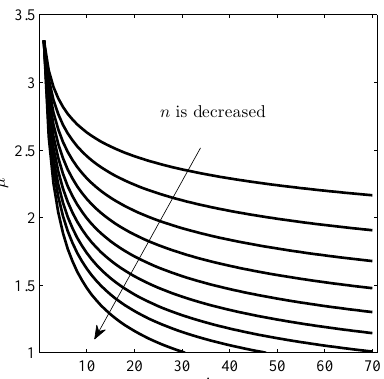
Figure 3. Representation of influence of power-law index, n , on non-Newtonian behaviour of a